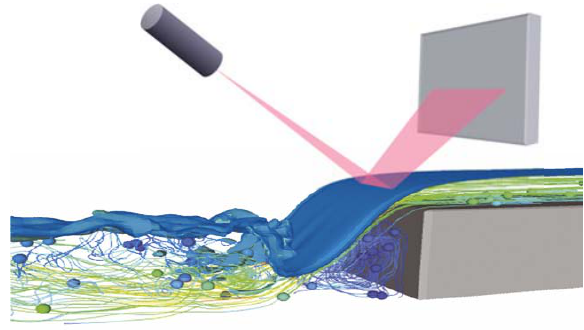
Figure 2: Basic measurement principle